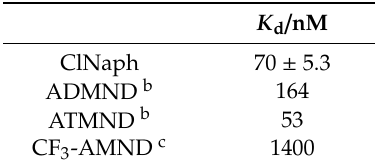
Figure 2. Fluorescence response of ClNaph (500 nM) to target AP–DNA duplexes (500 nM). Inset: Titration curves for the binding of ClNaph (500 nM) to target nucleobases. Measurements were done in solutions buffered to pH 7.0 (10-mM sodium cacodylate) containing 100-mM NaCl and 1.0-mM EDTA. F and F 0 denote the fluorescence intensities of ClNaph in the presence and absence of DNA duplexes. Excitation, 350 nm. Analysis, 393 nm. Temperature, 20 °C. Table 1. Dissociation constants ( K d ) of ClNaph and its related derivatives for target C in 21-meric AP–DNA duplexes a